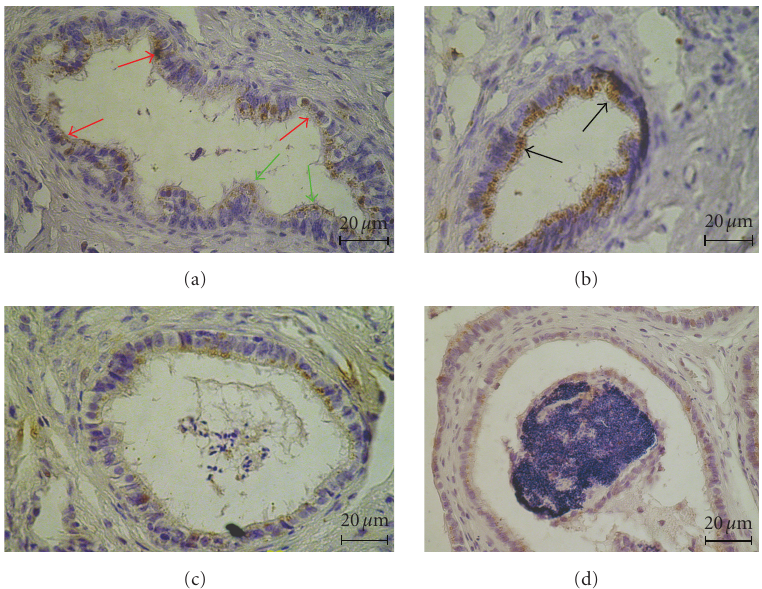
Figure 2: The distribution of FSH-R in the ductuli e ff erentes (a) and the epididymis (b–d) of man. (a) The cytoplasm of nonciliated (red arrow) and the apical cytoplasm of ciliated cells (green arrow) of the ductuli e ff erentes was positive for FSH-R. (b) The immunoreaction for FSH-R was more intensive in the apical cytoplasm of all principal cells of the caput epididymis (black arrows). (c-d) The decreasing intensity in the cytoplasm of groups of principal cells of the corpus (c) and the cauda epididymis (d) Scale bar: 20 μ